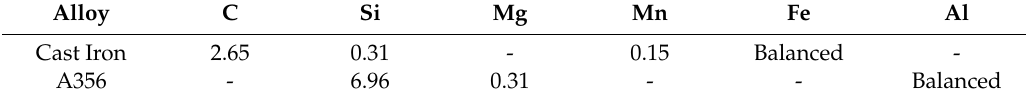
Table 1. Chemical compositions of gray cast iron (insert) and A356 casting alloy (wt.%).